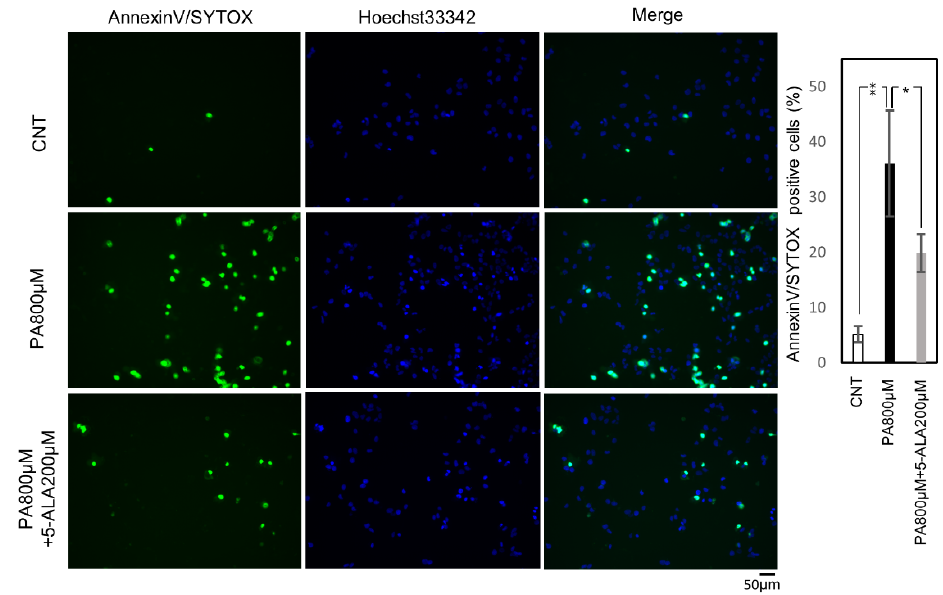
Figure 4. Cell death assay. Huh-7 cells were treated with 1% BSA for the control, and palmitic acid 800 μ M with or without 5-ALA 200 μ M for the treatment groups. The results were expressed as the ratio compared with the control. The quantification is based on ten randomly captured fields in each group. Bars indicate average ± SEM. * p < 0.05, ** p < 0.01. CNT, control; PA, palmitic acid.